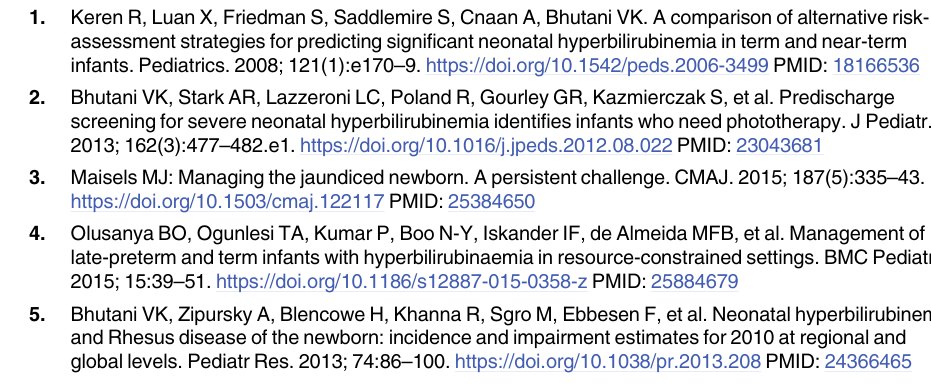
S1 Table. Questionnaire on neonatal hyperbilirubinemia management on East Java, Indo- nesia (Translated from Bahasa Indonesia to